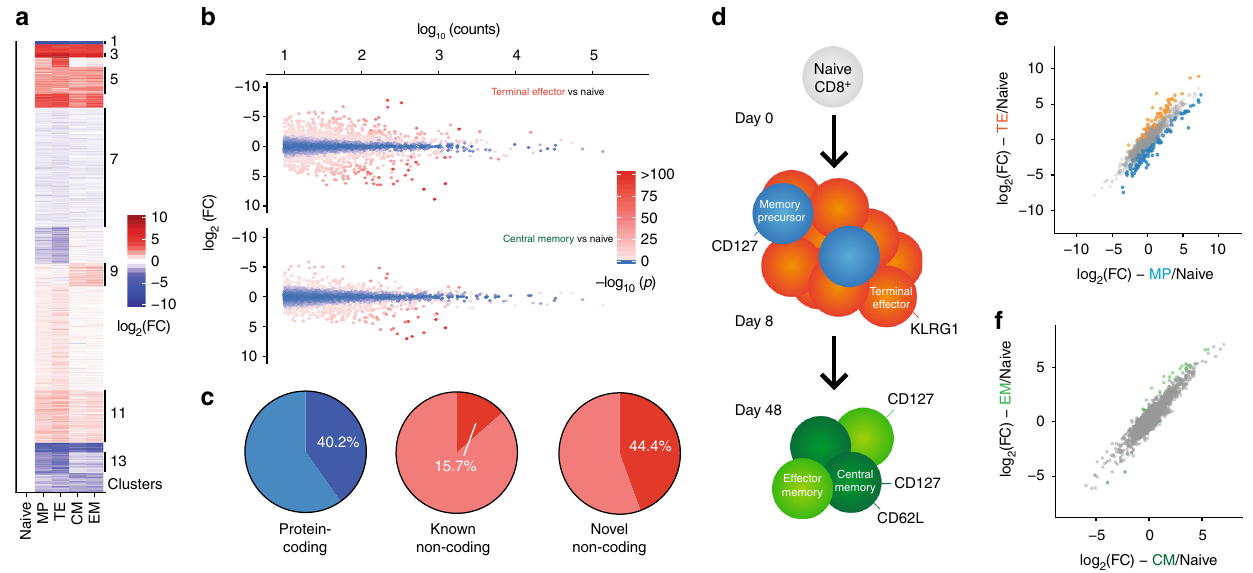
Fig. 2 Mouse CD8 + T cell differentiation is marked by large changes in lncRNA gene expression. a Heatmap showing expression of all differentially expressed genes in CD8 + T cells during the response to LCMV Armstrong. b MA plot of noncoding genes in day 8 terminal effector (TE) and day 48 central memory (CM) CD8 + T cells compared to naive cells. c 40.2% of expressed, known protein-coding genes are differentially expressed throughout CD8 + T cell differentiation, compared to 15.7% of previously-annotated lncRNA genes. However, 44.4% of lncRNA genes discovered in this study are differentially expressed throughout CD8 + T cell differentiation. d At day 8 and 48, two subsets of CD8 + T cells were sorted. Differences in noncoding gene expression between these subsets are shown in ( e ) and ( f ). Colored points indicate signi fi cant expression differences between the two cell subsets.